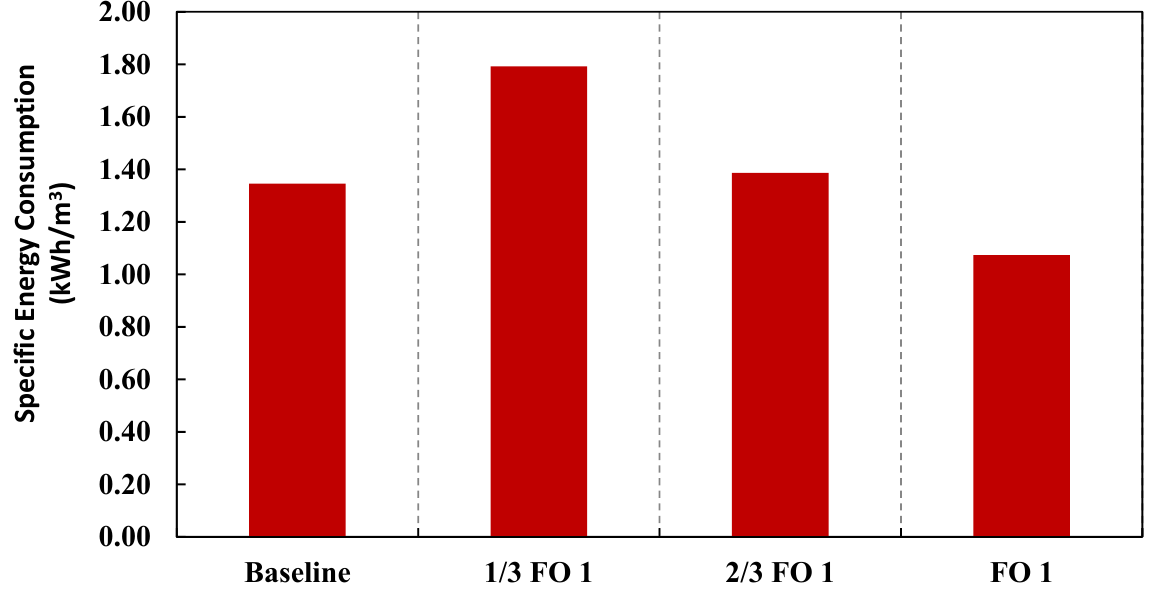
Figure 14. Overall capital costs of the various capacities of the water reuse plant if water reuse plants were reduced by 1/3 and 2/3, labeled as 1/3 FO 1 and 2/3 FO 1,